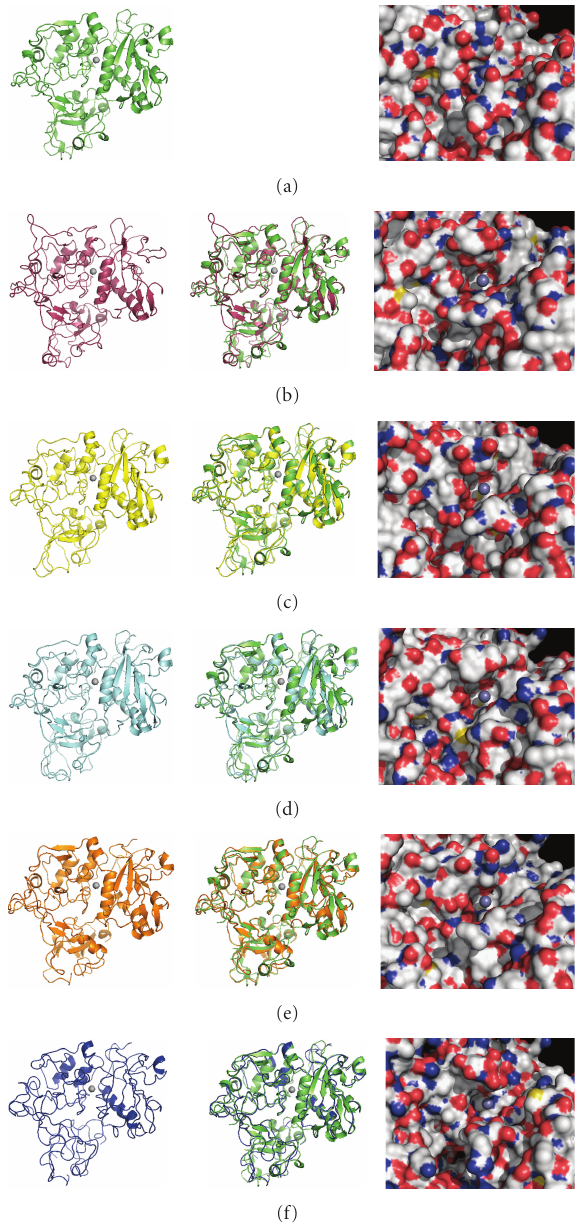
Figure 2: Predicted structures of T. congolense MSP homologues. Predicted amino acid sequences for each homologue were submitted for molecular modeling to the 3D-JigSaw comparative modeling web server (http://bmm.cancerresearchuk.org/ ∼ 3djigsaw/). The solved Leishmania GP63 crystal structure 1LML.pdb was chosen by the program (independently of the user) as the best fit as a modeling template for each protein. The resulting generated pbd structure files were visualized using PyMOL Molecular Graphics System Version 1.1r1. Individual structures on the left side of the figure are as follows: (a) Leishmania GP63 (1LML.pdb), (b) TcoMSP-D, (c) TcoMSP-B1, (d) TcoMSP-A, (e) TcoMSP-C, and (f) TcoMSP-E. The center column depicts an overlay of that structure with the structure of Leishmania GP63. The third column depicts a surface representation of each predicted structure and Leishmania GP63 on the face containing the putative active site. Red- orange regions denote oxygen atoms, blue regions denote nitrogen atoms, green denotes carbon and hydrogen atoms, and yellow denotes sulfur atoms. The light grey sphere indicates the position of the Zn 2+ ion in the solved Leishmania GP63 structure. It has been modeled into the predicted structures as an aid to